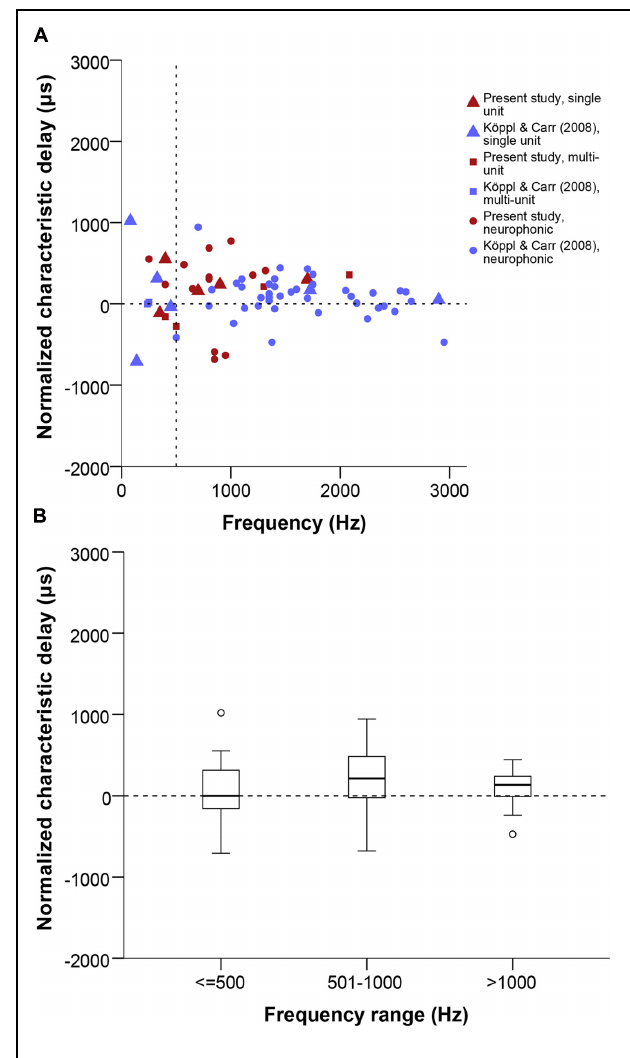
FIGURE 6 | (A) Normalized CD in µ s as a function of stimulus frequency (Hz). Triangles represent single unit recordings, squares represent multiunit recordings and circles represent neurophonics. The acoustic midline at 0 µ s ITD is marked by a horizontal dashed line and a vertical dashed line marks the 500 Hz position. Red data points are data from this study, blue data points are data from Köppl and Carr (2008). (B) Box plot of the CD distribution of all datasets and recording types in µ s at different frequency ranges, expressed in Hz. Solid bars represent the median, boxes represent the interquartile range. Whiskers represent the maximum and minimum of the distribution, circles and stars mark outliers. Negative values represent ipsilateral-leading sounds and positive values represent contralateral-leading